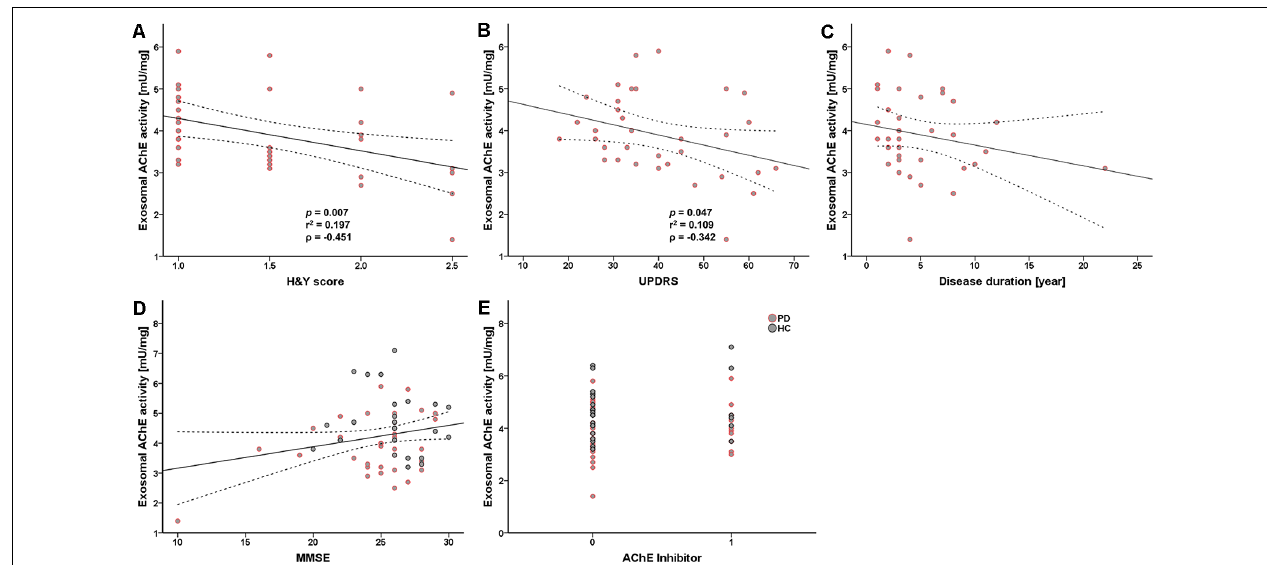
FIGURE 3 | Scatter plot of exosomal AChE activity and clinical data. Correlation between AChE activity and H&Y scores (A) , UPDRS part III score (B) , disease duration (C) , Mini-mental state examination (MMSE) score (D) , and AChE inhibitor use (donepezil, galantamine, and rivastigmine) (E) . 0 = without AChE inhibitors; 1 = with AChE inhibitors. The dashed line represents the 95% prediction interval of the regression line. ρ , Spearman’s rho. Spearman’s correlation analysis was used to determine any statistical